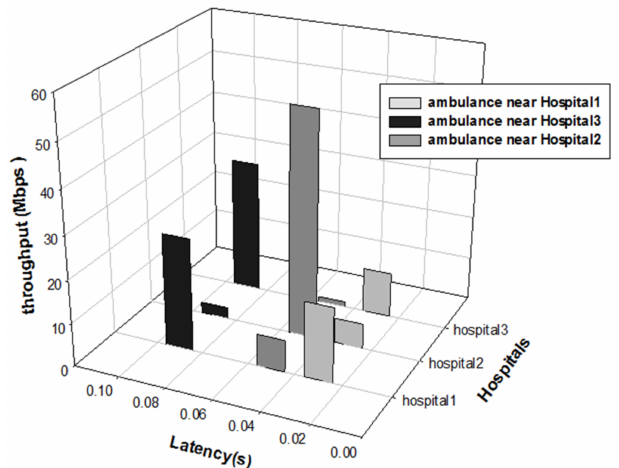
Figure 13. Throughput across round-trip distance latency.